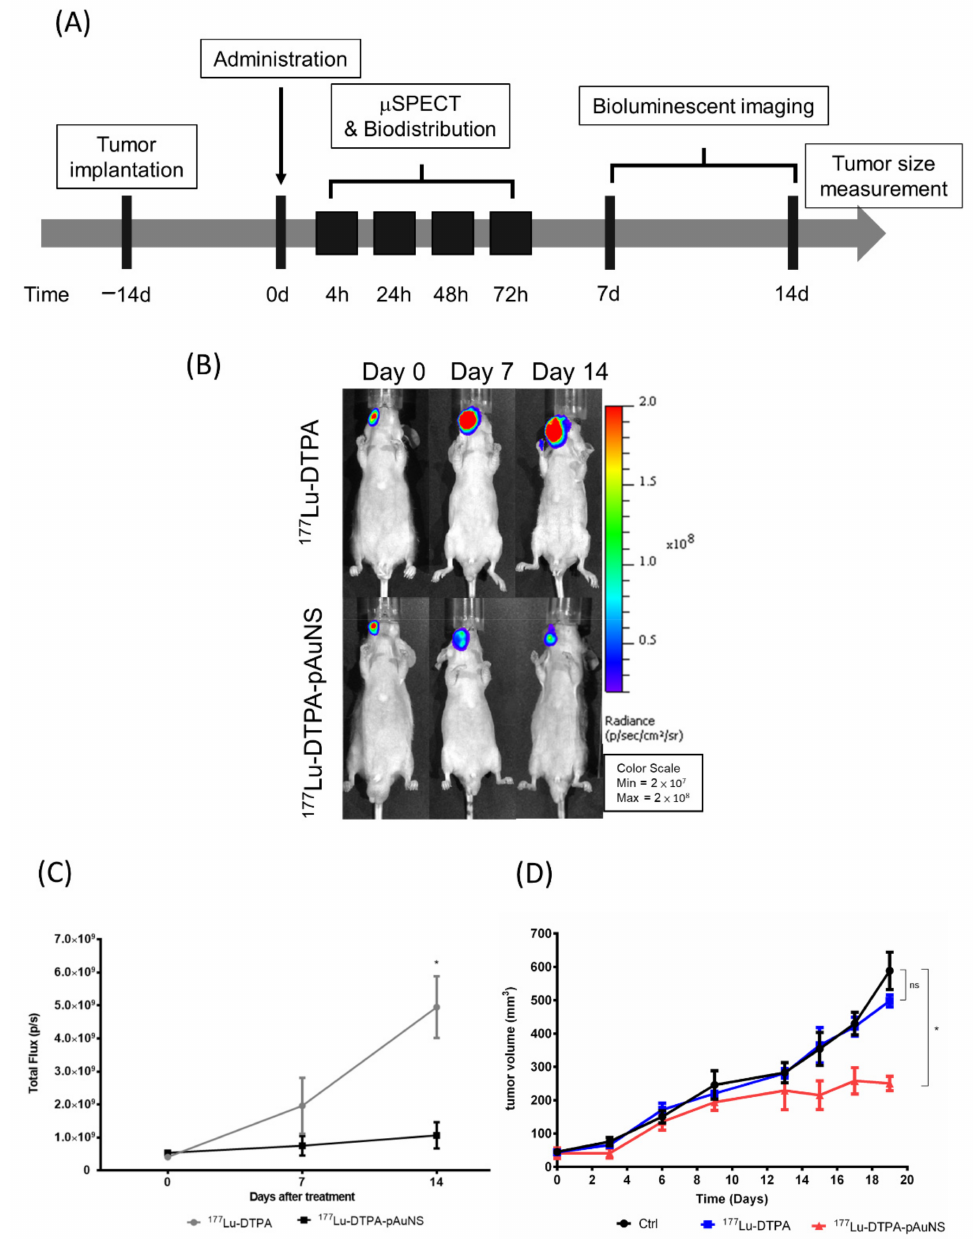
Figure 4. Monitoring the therapeutic efficacy of 177 Lu-DTPA-pAuNS administrated in